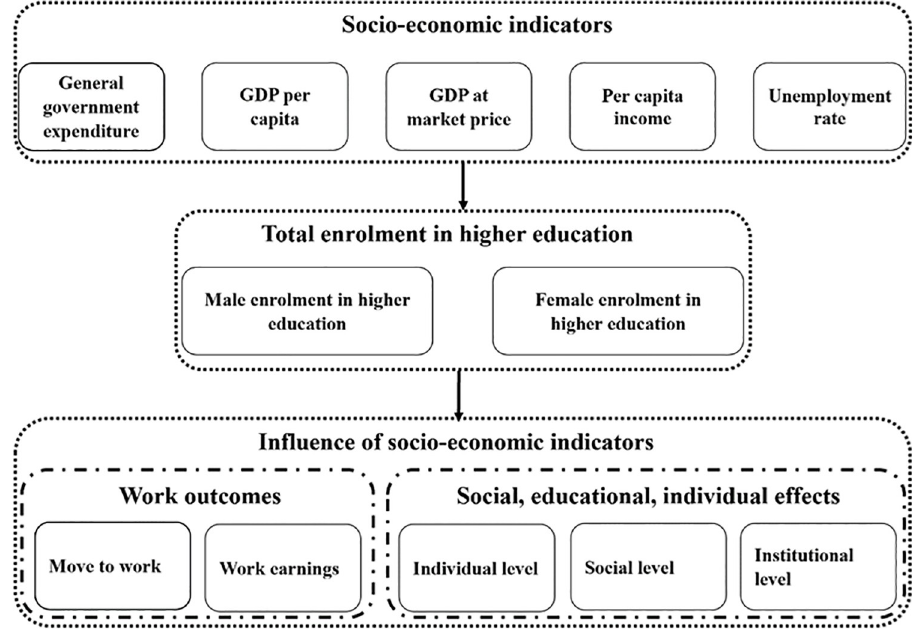
Fig 1. Conceptual framework of the